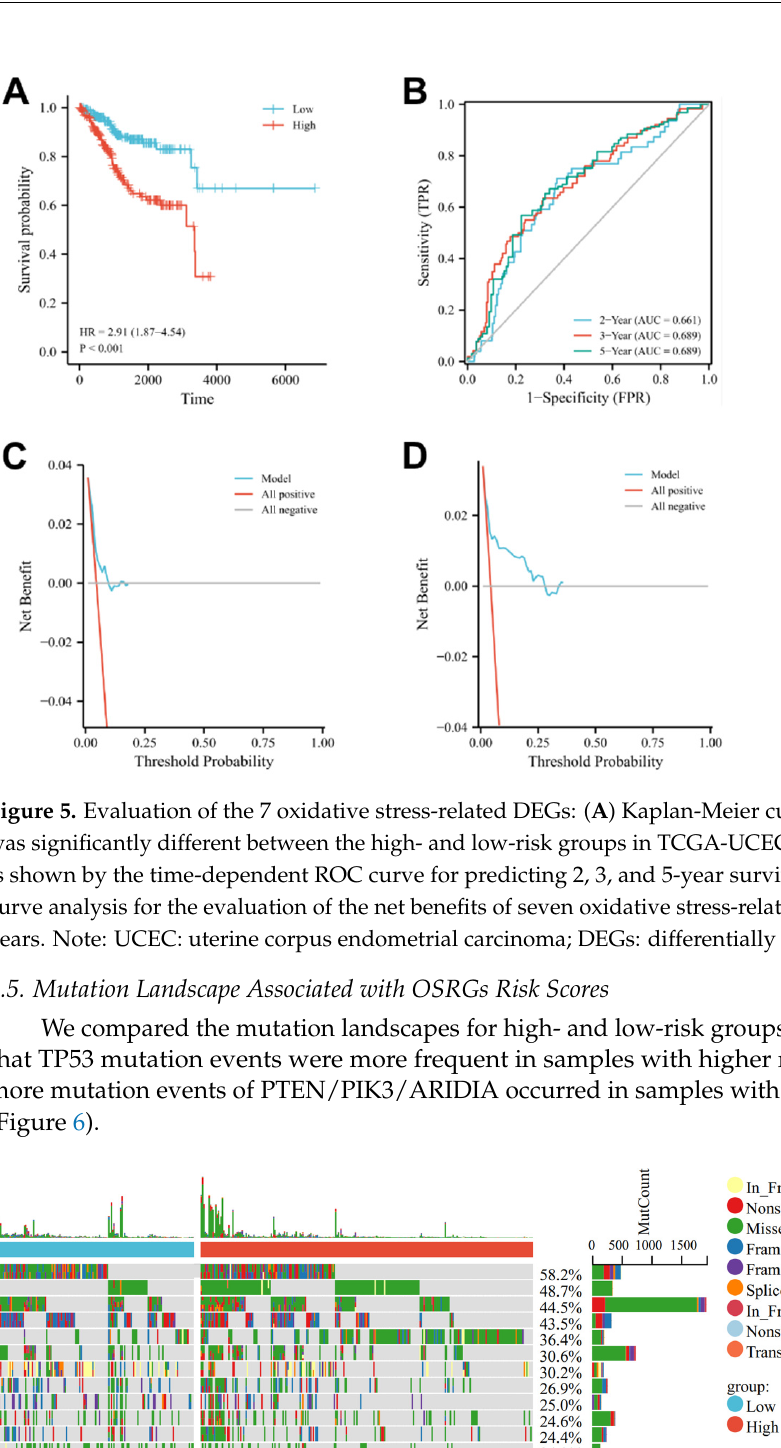
Figure 6. Comparison of somatic mutations between different risk subtypes. 3.6. Immune Status Analysis An analysis of the association between OSRGs-related risk and immune status was conducted in the TCGA cohort. The low-risk group exhibited considerably elevated per- centages of CD8 T cells. There was a stronger tumor immune response in the low-risk